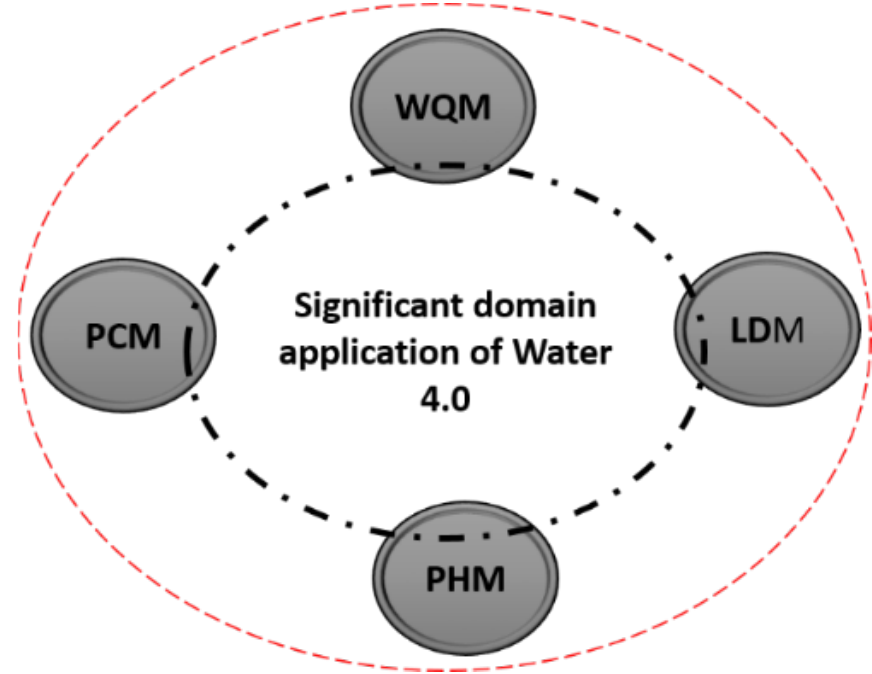
Figure 10. Water 4.0 significant water supply system application domain.